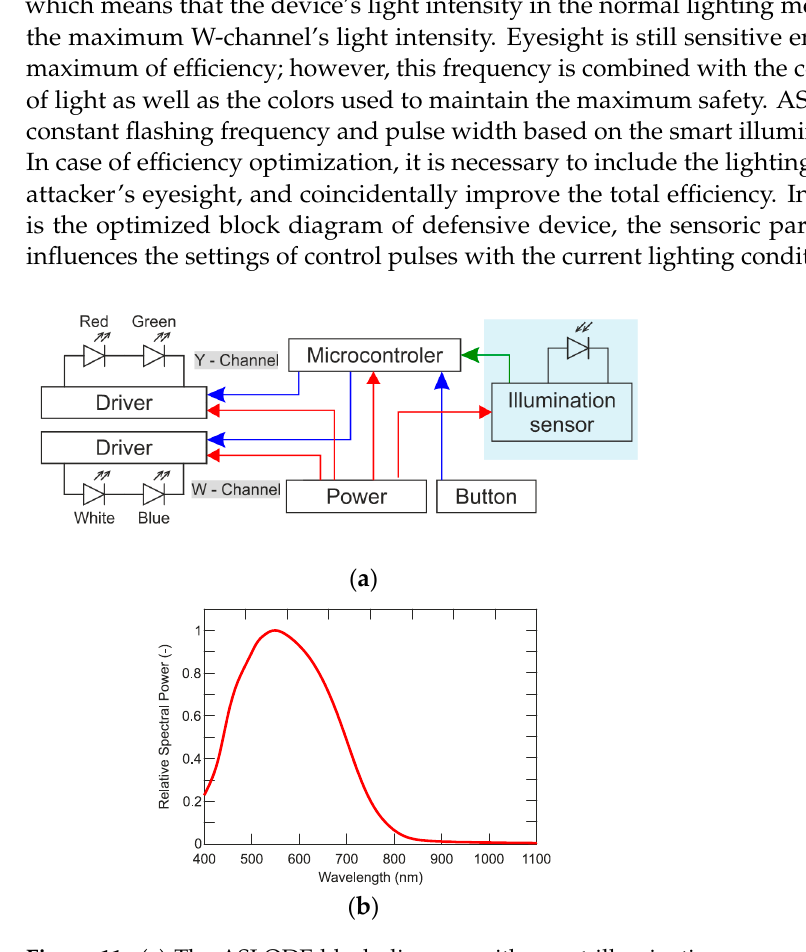
Figure 11. ( a ) The ASLODE block diagram with smart-illumination sensor; ( b ) relative spectral intensity of sensor (adapted from [45]).